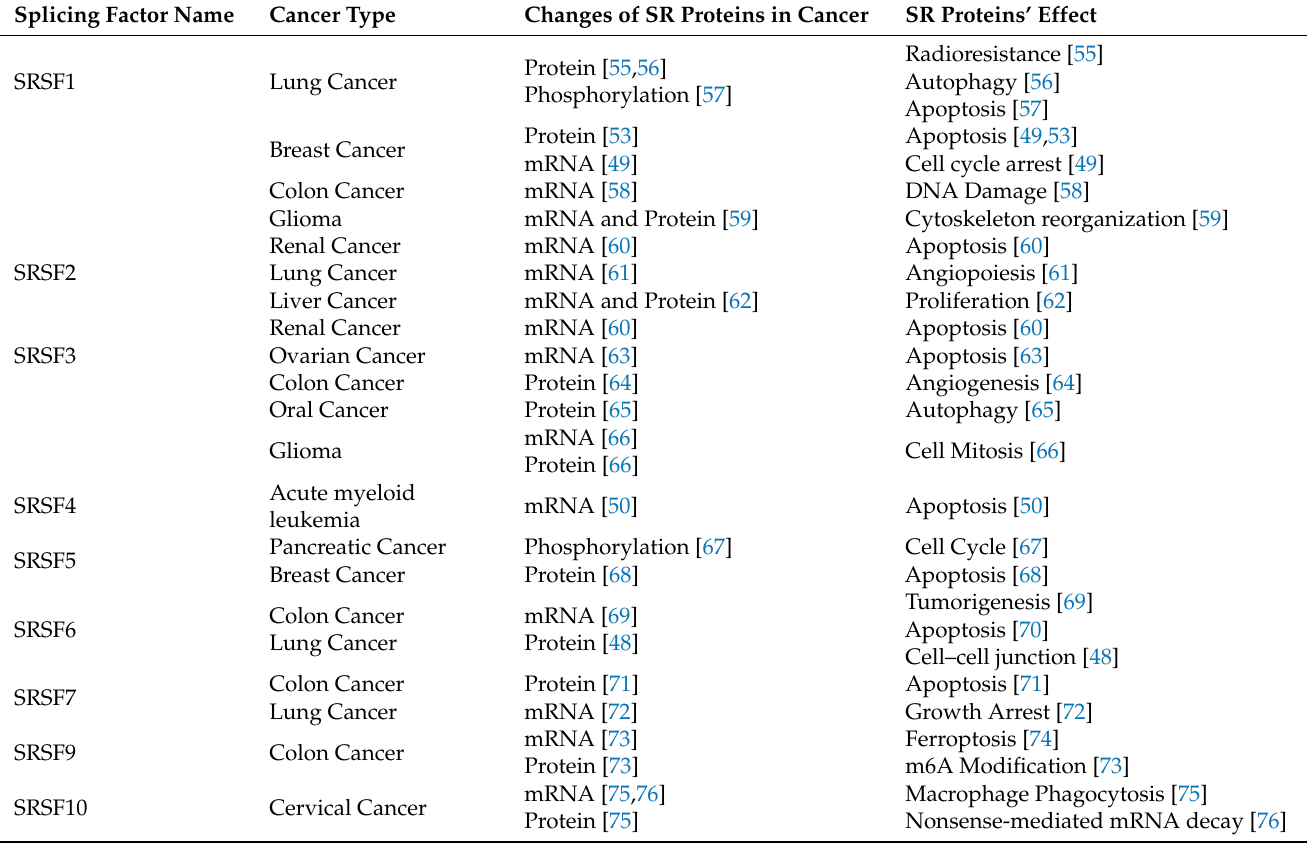
Table 1. The effects of SR proteins in cancer